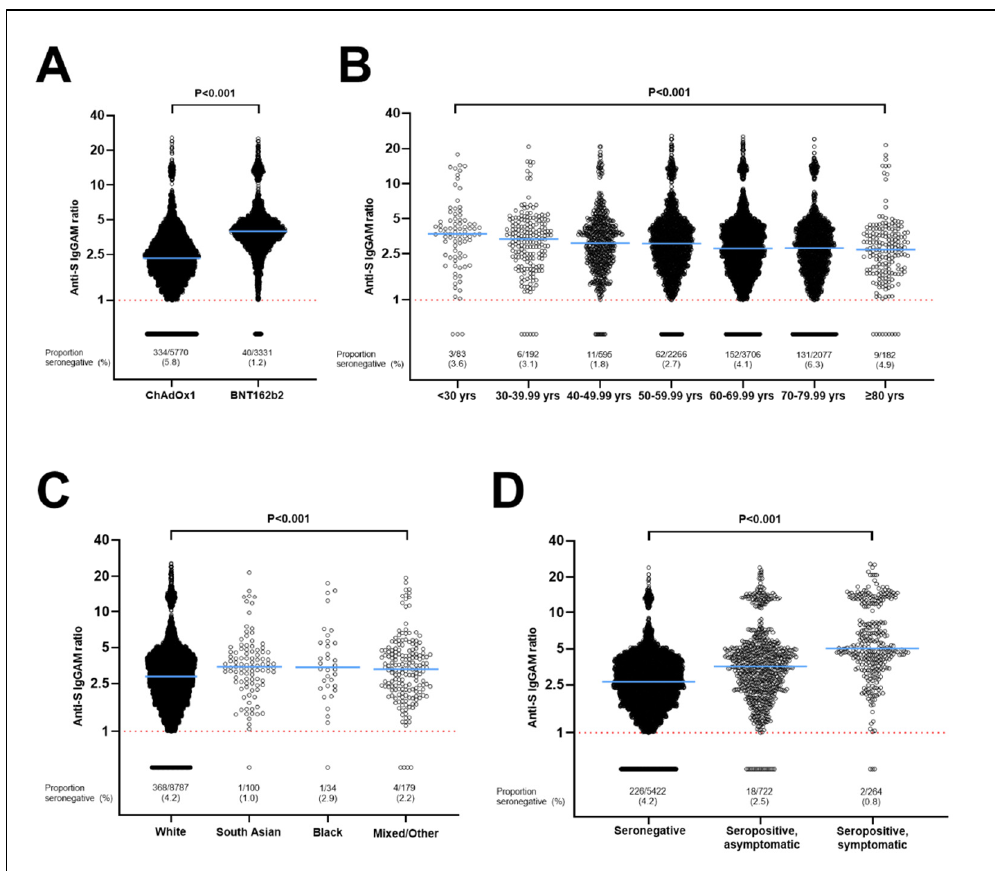
Figure 1. Antibody titres following two doses of vaccine by type of vaccine ( A ), age ( B ), ethnicity ( C ) and pre-vaccination SARS-CoV-2 status ( D ). For C, South Asian indicates people who self-identified their ethnic origin as Indian, Pakistani, or Bangladeshi, and Black indicates people who self-identified their ethnic origin as Black, African, Caribbean or Black British. p values from Mann–Whitney test ( A ) and Kruskal–Wallis tests ( B – D ). Anti-S, anti-spike; IgGAM, immunoglobulin G, A or M. Dotted line = limit of detection.